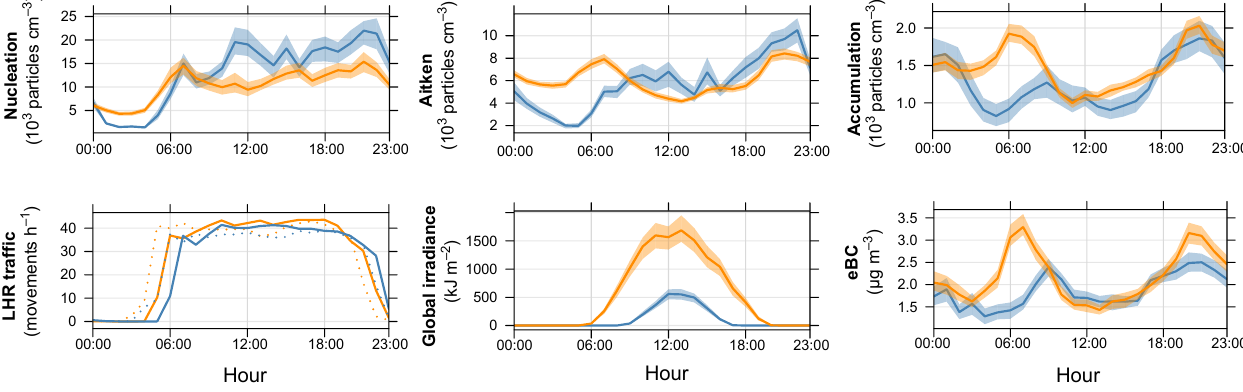
Figure 2. Diurnal patterns of PNC, LHR traffic, solar irradiance and eBC. Plots report the average levels as a filled line and the associated 95th confidence interval calculated by bootstrapping the data ( n = 200). Outliers (data > 99.5th percentile) were removed for computing the diurnal patterns. Hours are given in UTC. LHR traffic movements (bottom right plot) are reported as arrivals (dotted lines) and departures (solid lines). The offset between the seasons is largely due to daylight saving time (BST: UTC + 1) in the summer data. The diurnal patterns of all the measured variables are reported in Fig.